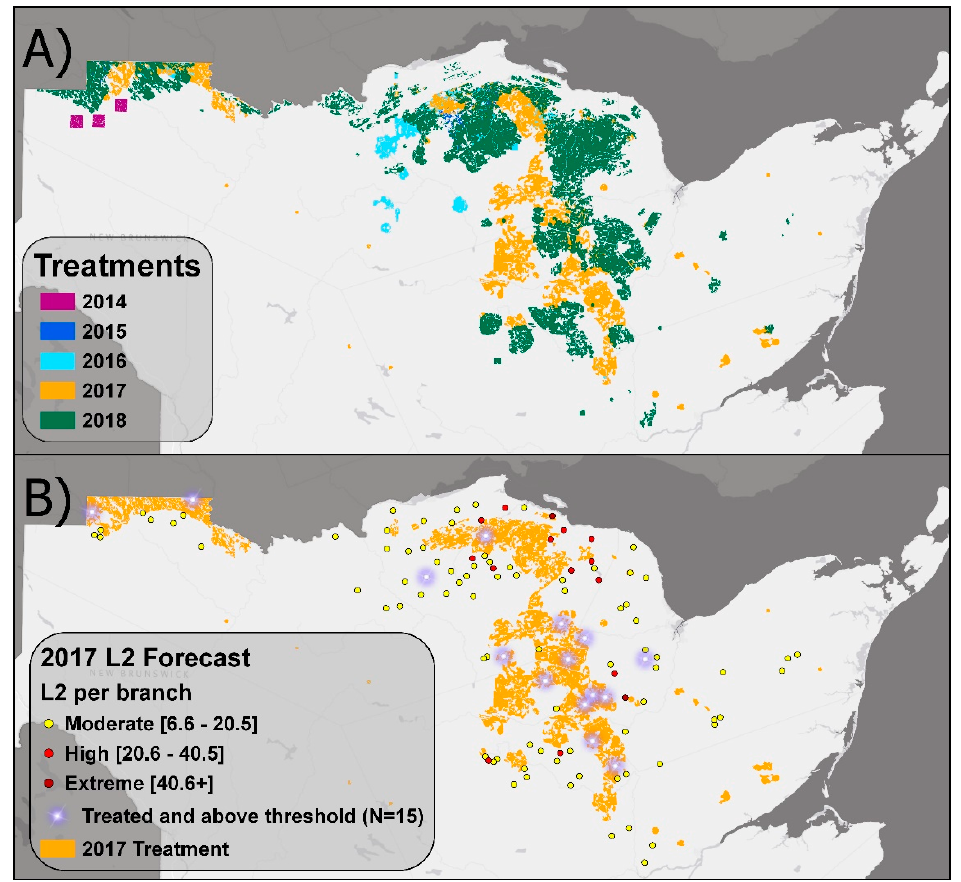
Figure 6. ( A ) Successive areas treated with Btk or tebufenozide insecticides each year from 2014 to 2018. ( B ) Comparison of 2017 treatment areas and autumn 2017 L2 samples with ≥ 7 L2/branch.